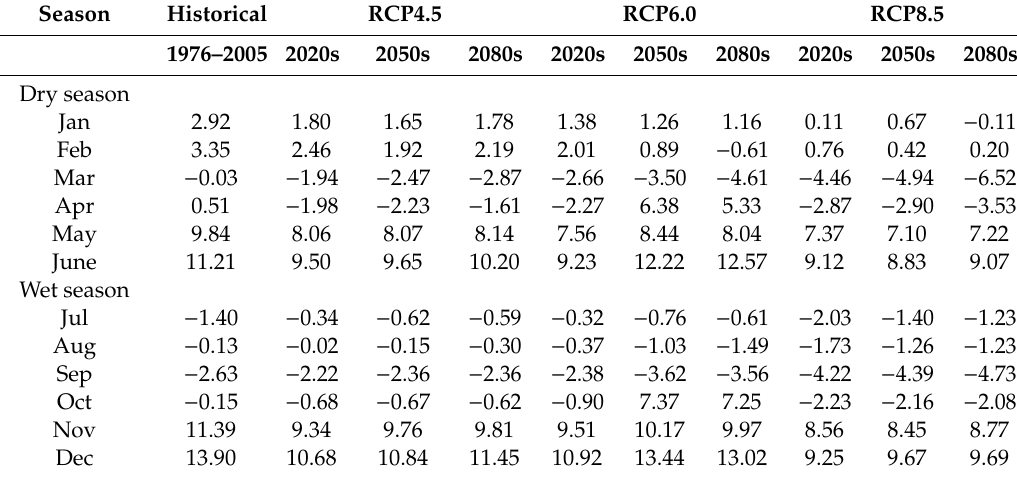
Table 6. Historical and projected water supply excess / shortage under RCP scenarios 4.5, 6.0, and